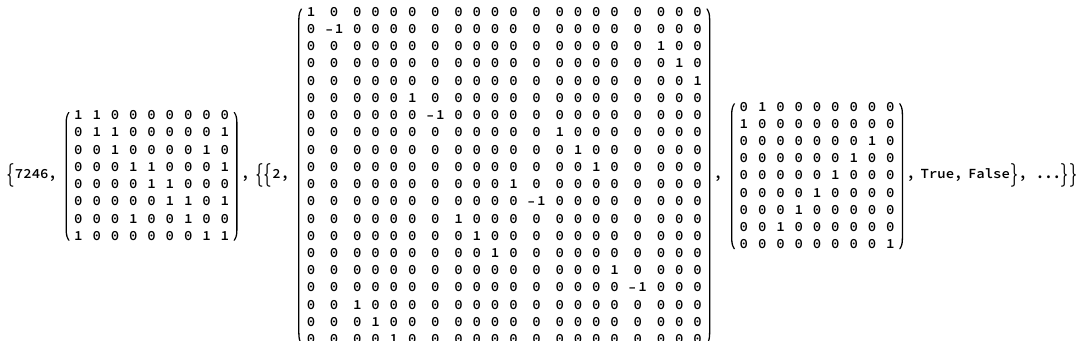
Figure 1 . A simple example illustrating the format described in the text. This example describes the symmetries associated to CICY 7246, the favorable configuration matrix for which is the second entry in this list. The third entry in the list is a list of symmetries of which only the first is shown explicitly. This symmetry is associated to an order 2 cyclic group with the action on the homogeneous coordinates being given by the first matrix and the action on the defining polynomials being given by the second. This particular example has been proven to lead to a smooth set of invariant defining relations but it is not know whether it corresponds to a new symmetry (although it is certainly a new representation of